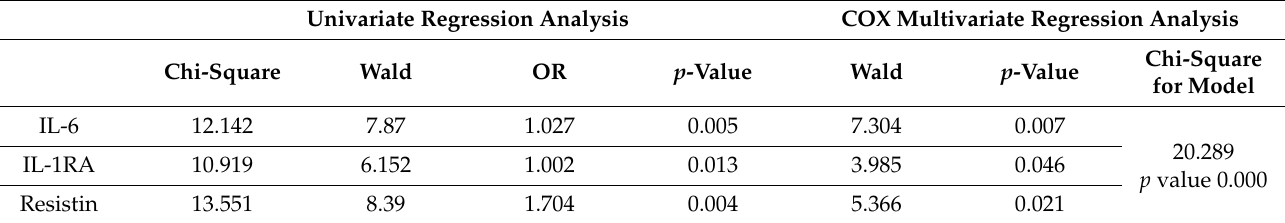
Table 6. ROC analysis—performance of MACE prediction using plasma cytokines. Univariate Regression Analysis COX Multivariate Regression Analysis